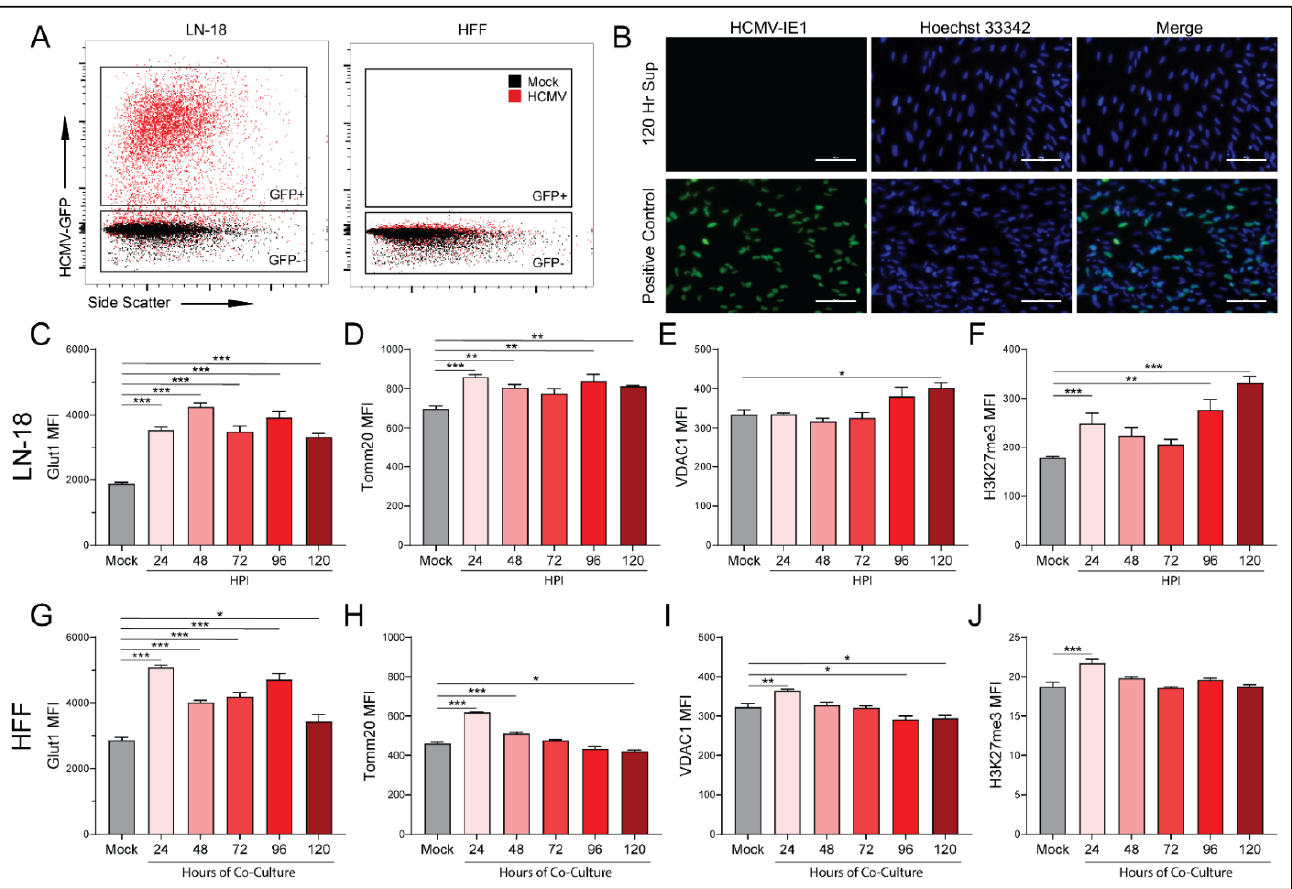
Figure 7. HCMV infected cells alter metabolic pathways of uninfected cells in a paracrine manner. Mock- and HCMV-infected LN-18 cells were co-cultured with HFFs as described in Figure 6D and then the separate populations were subjected to flow cytometry. Infection of LN-18 cells and absence of infection of HFFs was established following 120 Hr co-culture by ( A ) HCMV-GFP expression. A titer was performed on fresh HFFs using supernatant from the 120 Hr co-culture HFF compartment, to ensure an absence of viral infection, and cells which had been infected with HCMV as a positive control for the immunocytochemistry staining. ( B ) HCMV-IE1 staining was performed at 20× magnification. HCMV-IE1 is shown in green and Hoechst 33342 stained nuclei are shown in blue. Scale bar: 100 μM. Flow cytometry was used to quantify changes in glycolytic marker ( C , G ) Glut1, oxidative phosphorylation markers ( D , H ) Tomm20 and ( E , I ) VDAC1, and an epigenetic marker ( F , J ) H3K27me3 in infected LN-18 and non-infected HFF cells respectively. Graphs represent pooled data from three independent experiments. Mean ± the SEM of at least 3 triplicates. *, p < 0.05; **, p < 0.01; ***, p < 0.001.